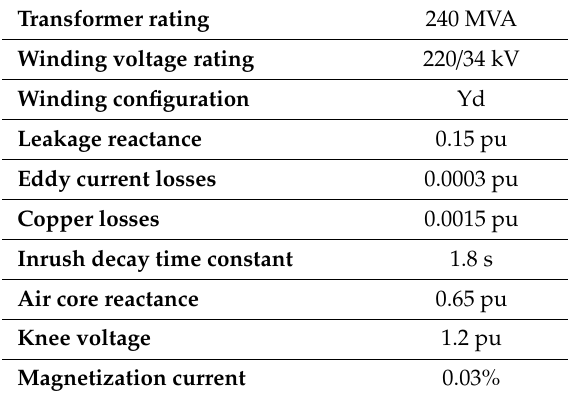
Table A4. The 220 / 34 kV, 240 MVA transformer data implemented in